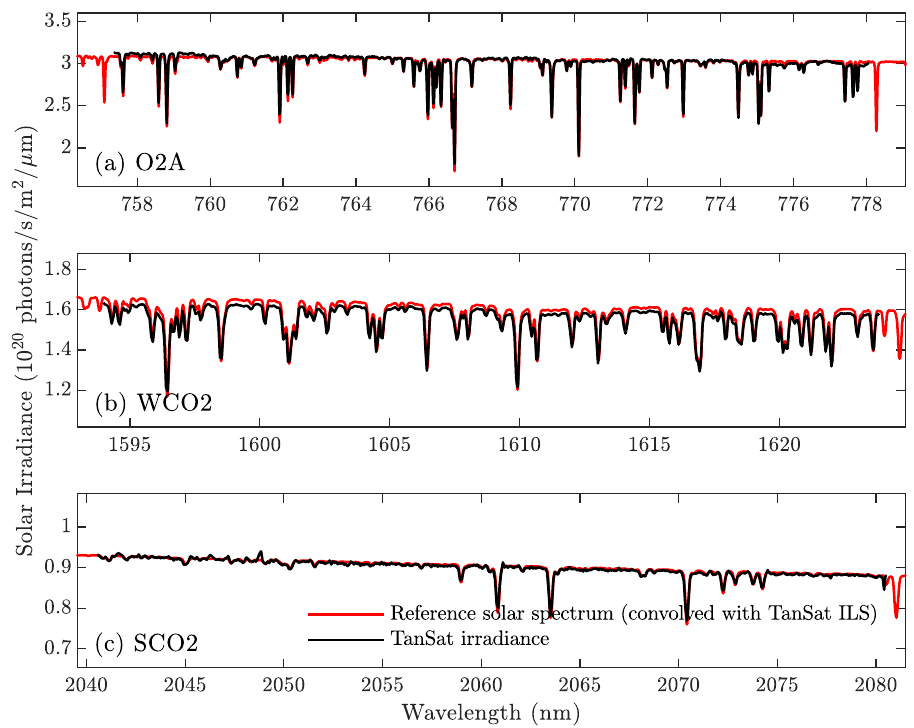
Figure 1. TanSat mean solar spectrum at ( a ) O2A, ( b ) WCO2, and ( c ) SCO2 bands, and comparison with the reference solar spectra convolved with TanSat ILS. TanSat solar measurements were from footprint 4 on 1 March